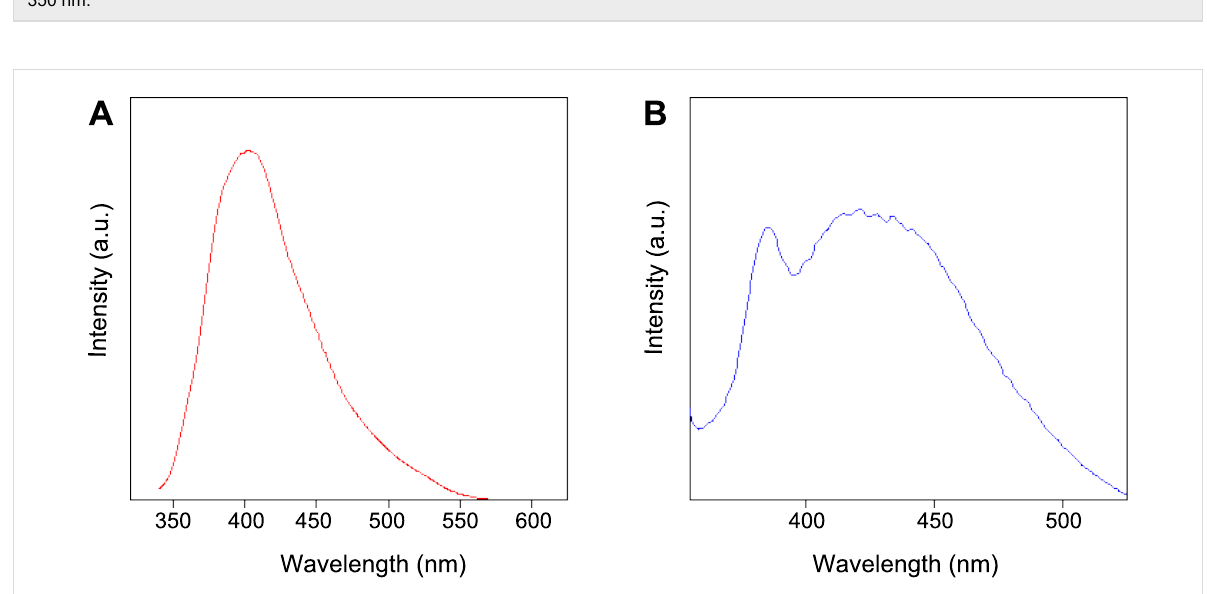
Figure 6: UV–vis spectroscopy of (A) Gd 2 O 3 nanoparticles showing a peak at 325 nm and (B) Gd 2 O 3 –taxol bioconjugate showing a shoulder at 350 nm.